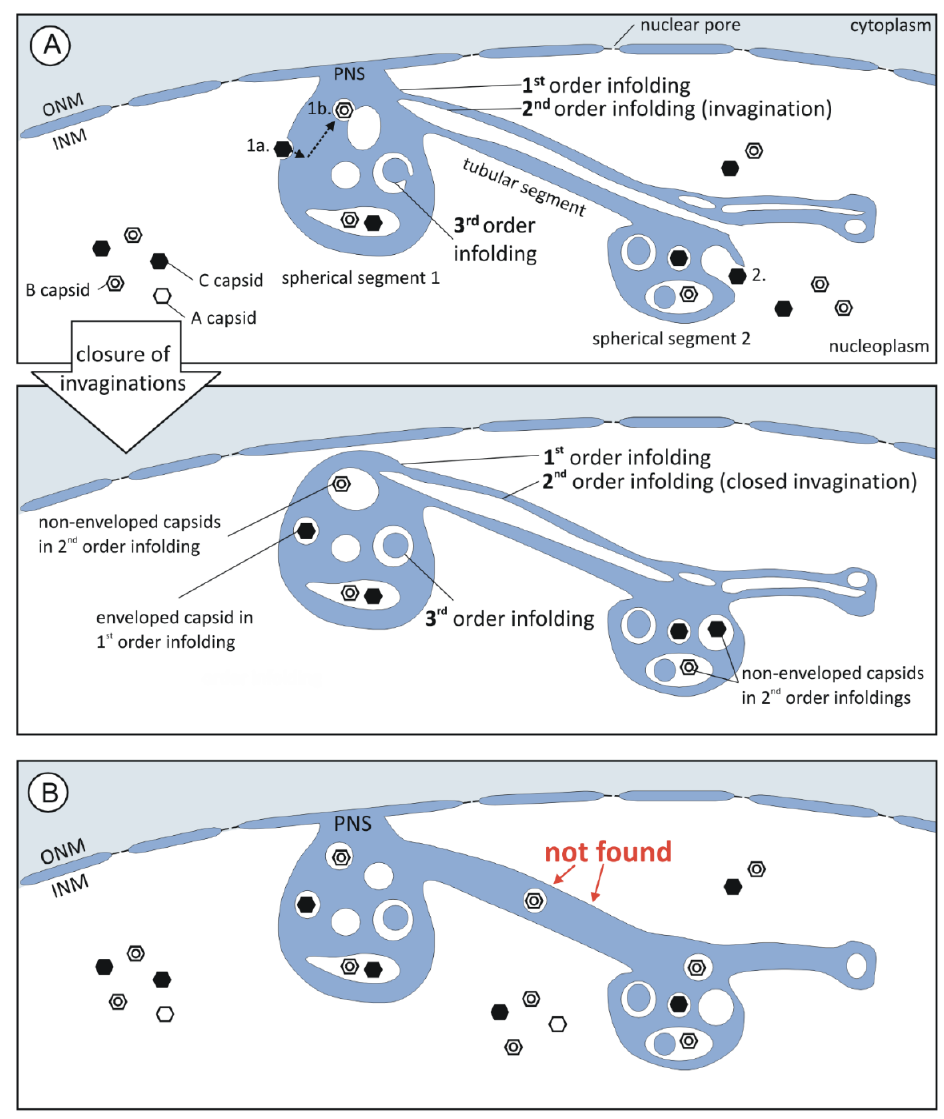
Figure 6. Summary of the architecture of intranuclear membrane structures revealed by FIB/SEM tomography. ( A ) Model describing infolding formation: The hierarchy of the compartments (1st, 2nd, and 3rd order infolding) could be explained by invagination of membrane into the respective compartment and subsequent membrane fission. Thus, the lumen of 1st and 3rd order infoldings equals the perinuclear space (PNS, blue) and the lumen of 2nd order infoldings the nucleoplasm (white). Non-enveloped capsids were only found in the nucleoplasm and 2nd order infoldings, enveloped capsids only in the lumen of 1st order infoldings; (1a.) It seemed obvious that enveloped capsids result from capsid budding into 1st order infoldings. (1b.) Capsid envelopes might be able to fuse with membranes of 2nd order infoldings, resulting in non-enveloped capsids in 2nd order infoldings; (2.) Alternatively, non-enveloped capsids in 2nd order infoldings could result from capsid trapping during formation of invaginations. ( B ) We never found tubular segments with capsids. Tubular segments always contained 2nd order infoldings.